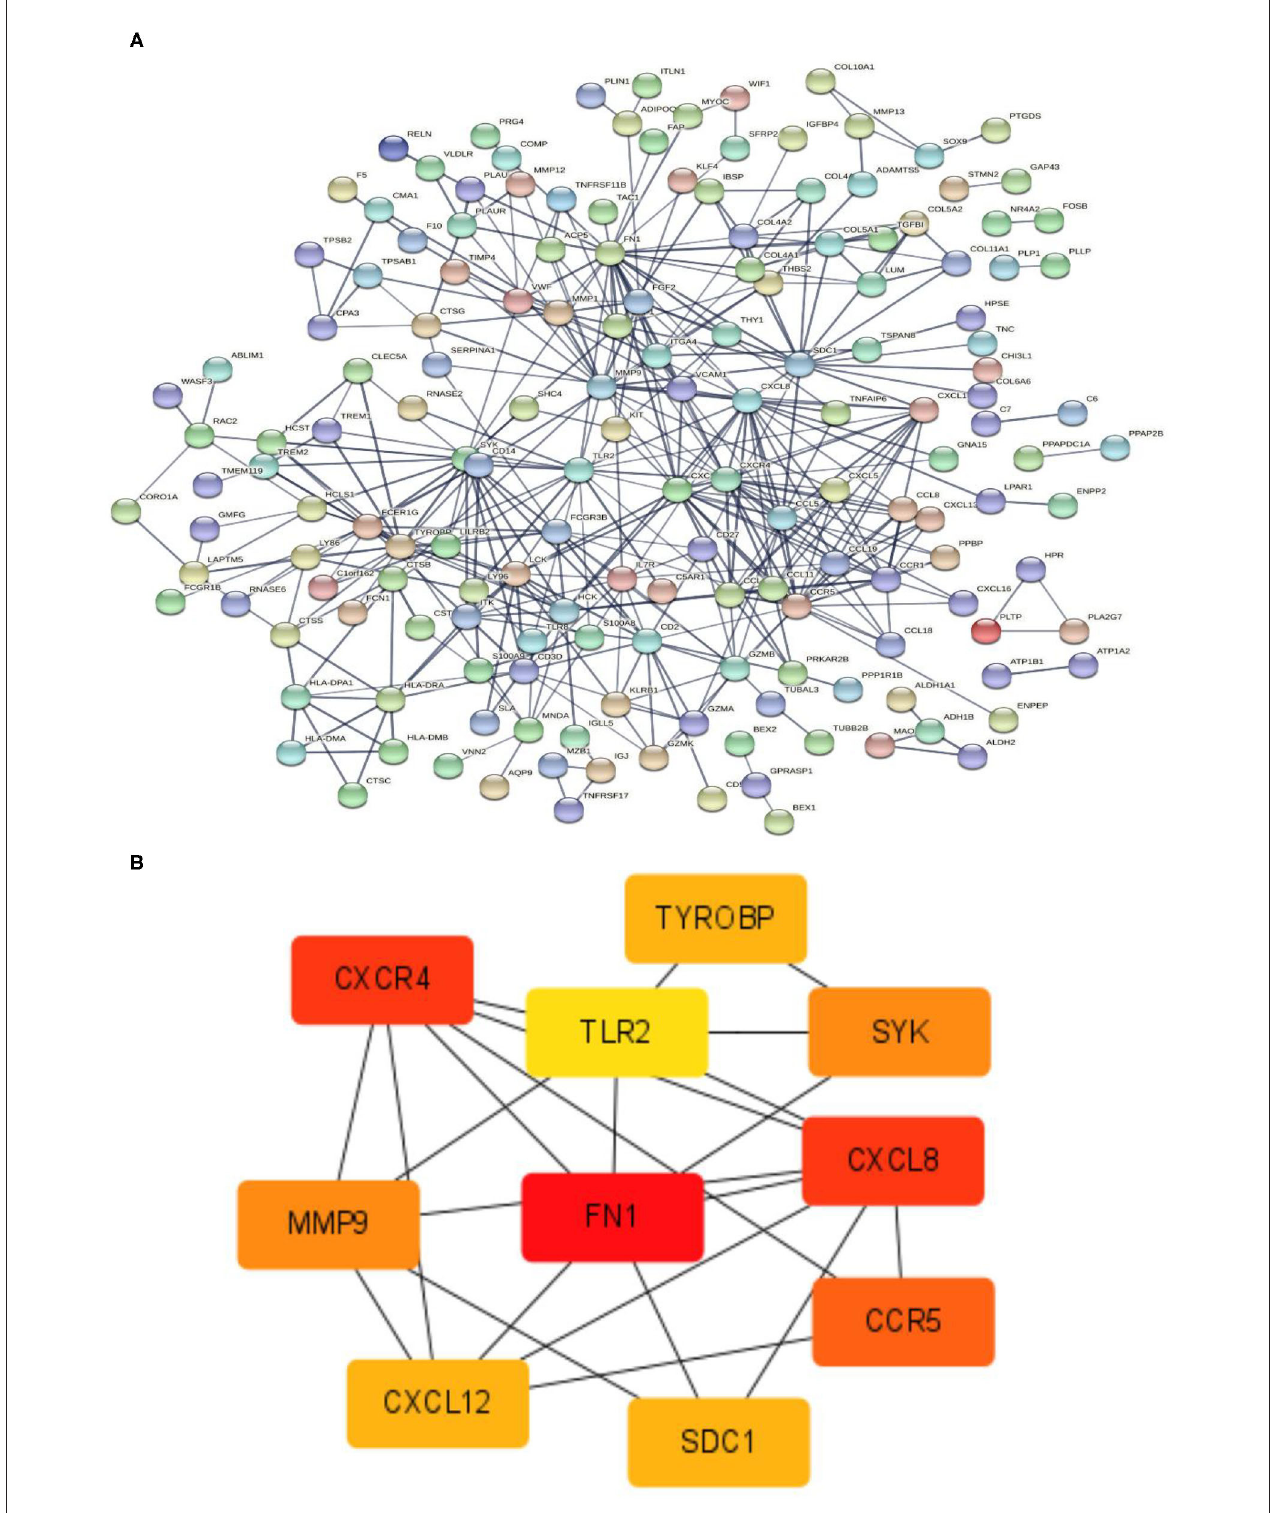
FIGURE 7 | PPIN and hub gene identification. (A) PPIN was constructed by all the 337 DEGs using STRING database. The protein-protein interactions are represented by linkages. The number of nodes: 320; the number of edges: 420; the average node degree: 2.62; the PPI enrichment p -value < 1.0e-16. (B) The top 10 hub genes in the PPIN were screened by Cytoscape (v3.6.1) plugin cytoHubba based on their connectivity degree. The 10 identified hub genes such as FN1, CXCL8, CXCR4, CCR5, MMP9, SYK, TYROBP, CXCL12, SDC1, and TLR2 are displayed from red (high degree value) to yellow (low degree value). PPIN, protein-protein interaction network; DEG, differentially expressed gene; STRING, search tool for the retrieval of interacting genes.